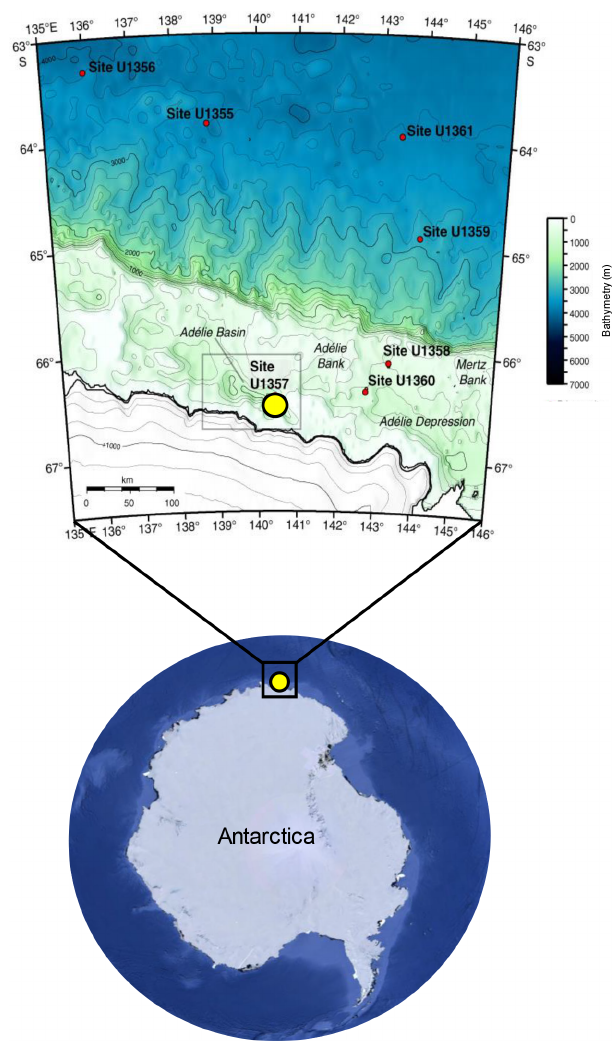
Figure 1. Location of the IODP318-U1357B core in the Adélie Basin, East Antarctica, indicated by a yellow dot (Antarctic image source © Google Earth; bathymetric map is reproduced from Escu- tia et al.,